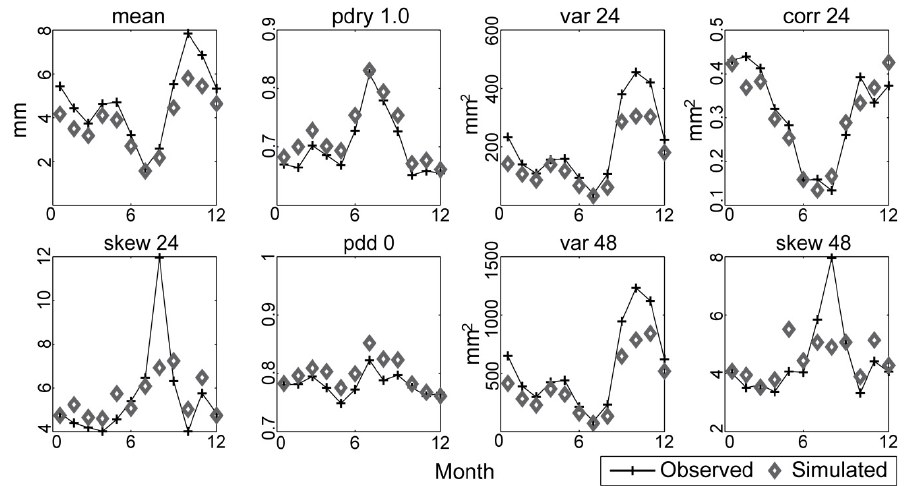
Figure 8. Calibration of RainSim V3 in the Gardons basin. Statistical values (rain gauge PH_0194).